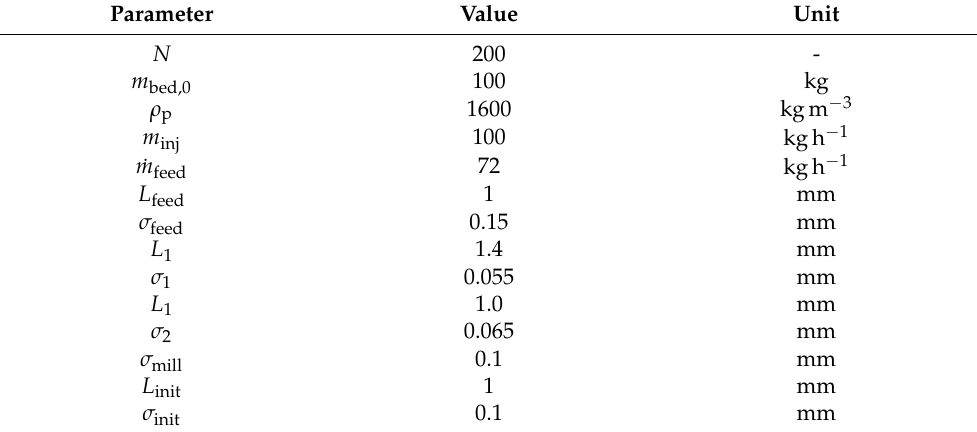
Table 2. (Nominal) simulation